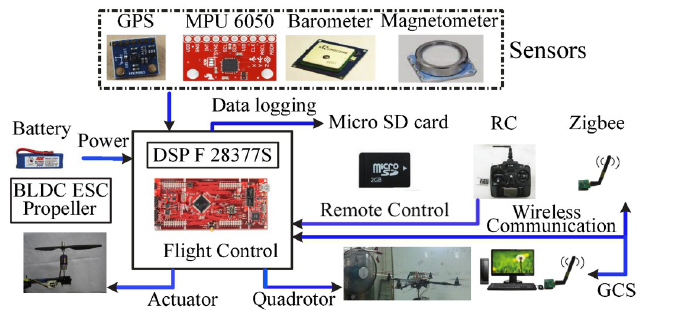
Fig 21. The quadrotor’s hardware